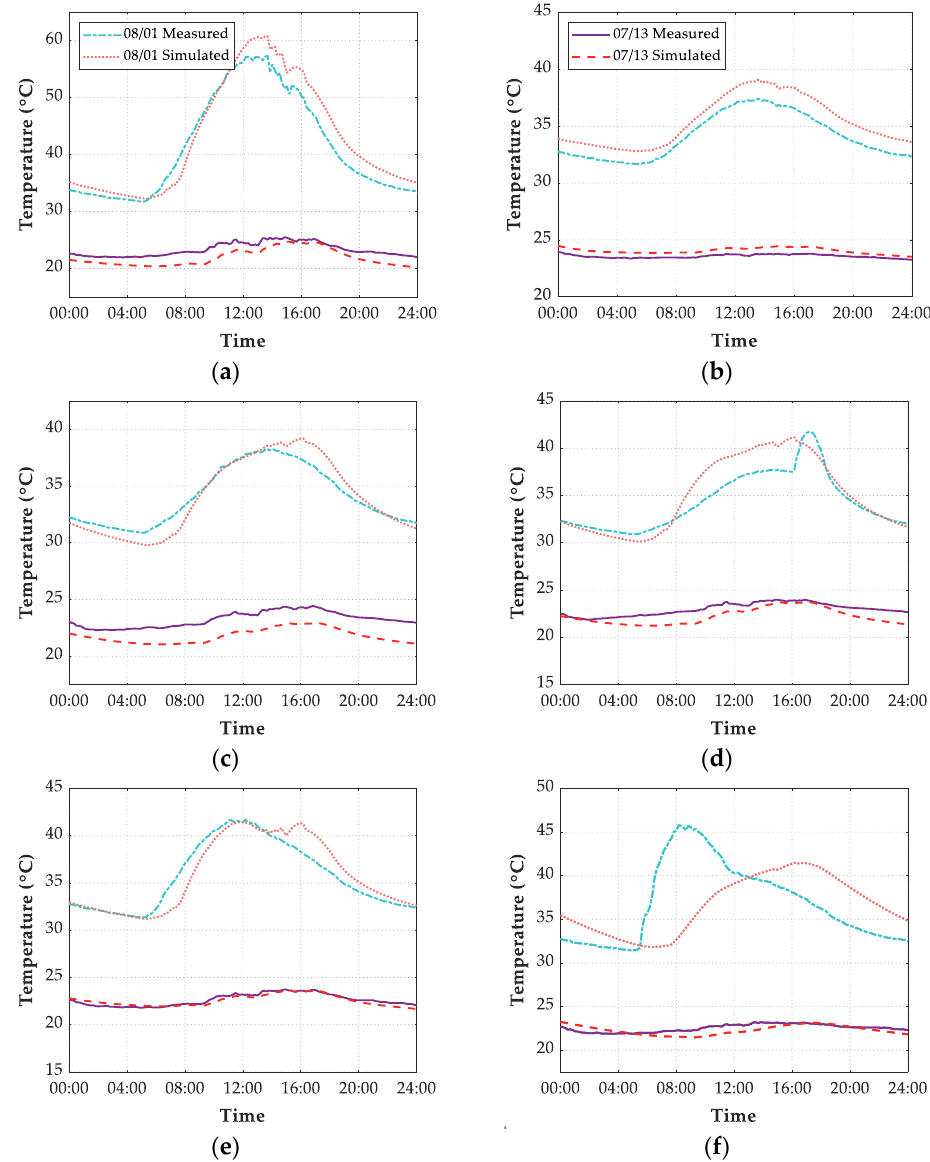
Figure 19. Comparison between FE simulated results and measured records of 6 points on 13 July 2019 and 1 August 2019. ( a ) TS; ( b ) BS; ( c ) SS; ( d ) NS; ( e ) SP; ( f ) EP.